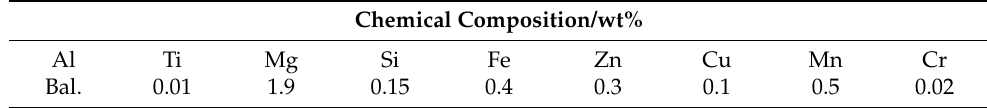
Table 1. Chemical Composition of 5251 Aluminum Alloy [29].